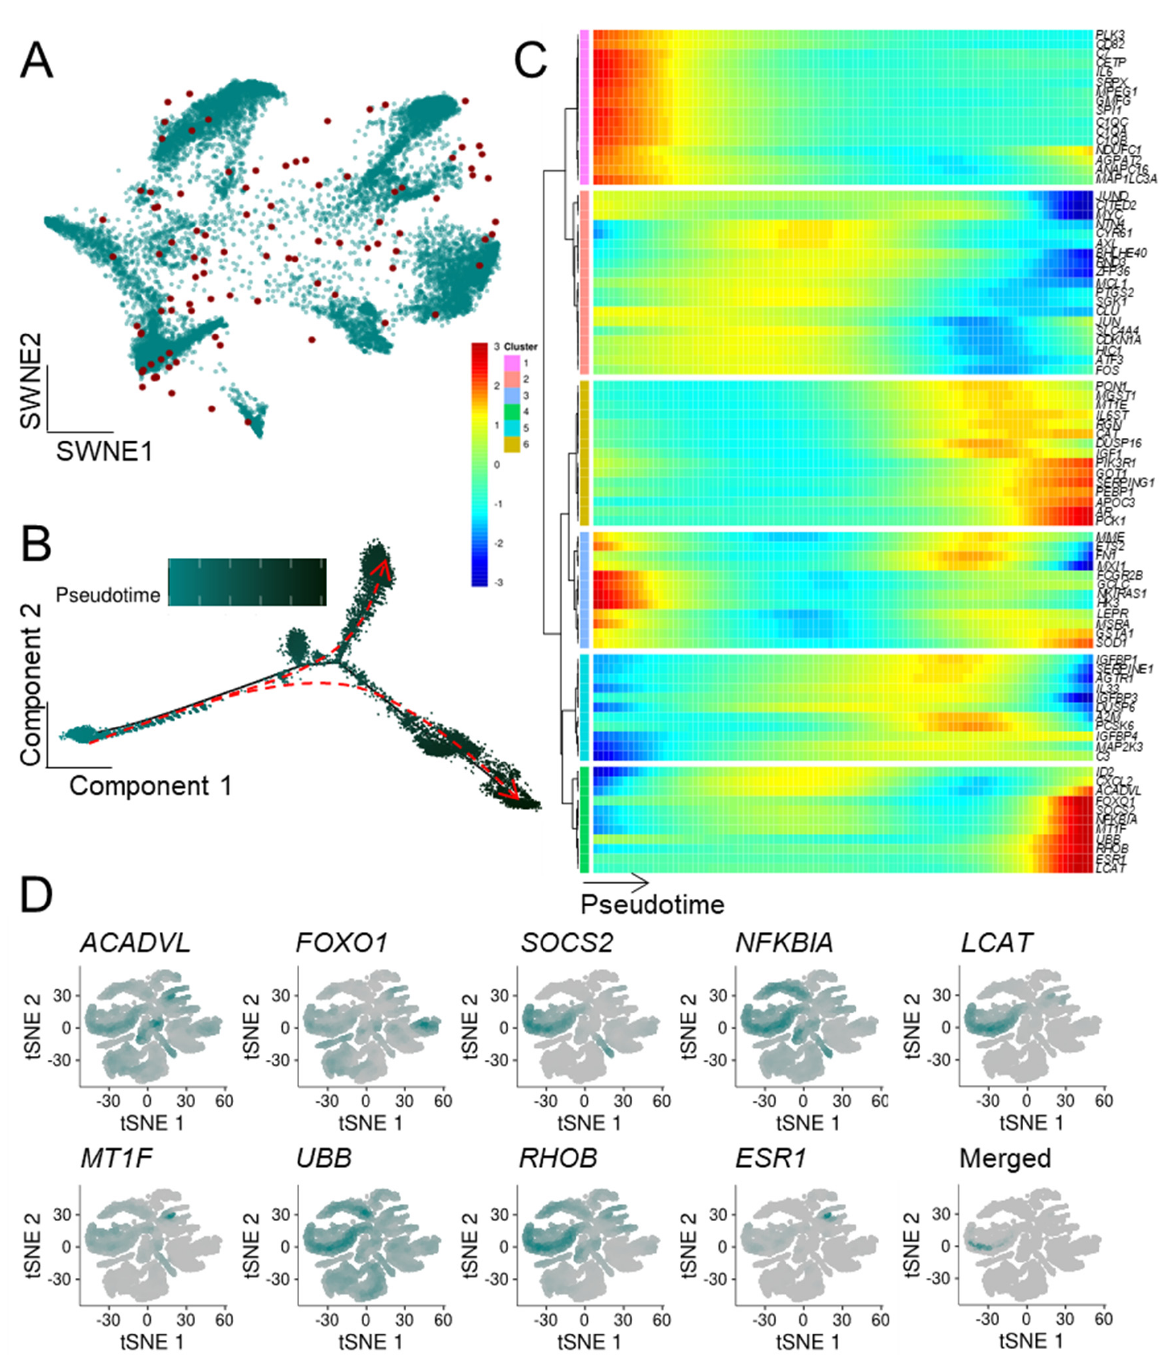
Figure 5. Hepatocytes display an upregulation of ASIGs in HCC. Hepatocytes isolated from a HCC scRNA-seq dataset containing samples of 46 patients were analyzed (GSE151530 [52]). ( A ) SWNE plot weighted based on 94 robustly expressed ASIGs (depicted as red dots) in HCC. ( B ) The cellular development of hepatocytes was presented in pseudotemporal ordering indicating an early (left, green) and late (right, black) fate. ( C ) Distinct gene clusters (mustard, green) showed significant upregulation of expression levels along pseudotime. ( D ) t-SNE plot displaying a cluster of cells highly expressing ASIGs genes during late development stages of hepatocytes.